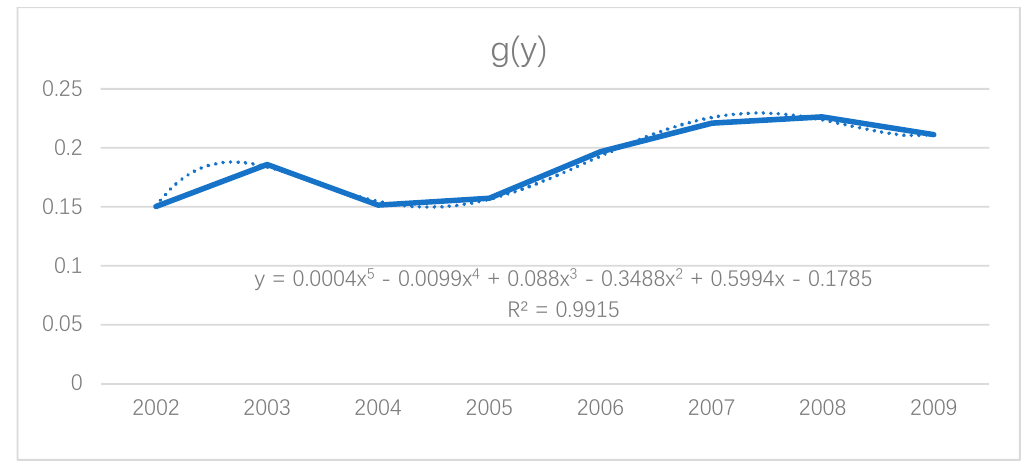
Figure 5. The comprehensive evaluation values of the socioeconomic and ecological environment benefits of land use.